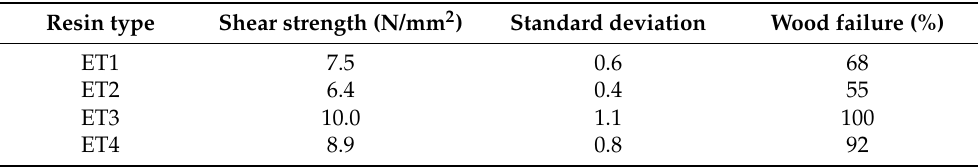
Table 3. Shear strength of block shear wood joints tested according to norm EN 12675:2002 [13]. Resin